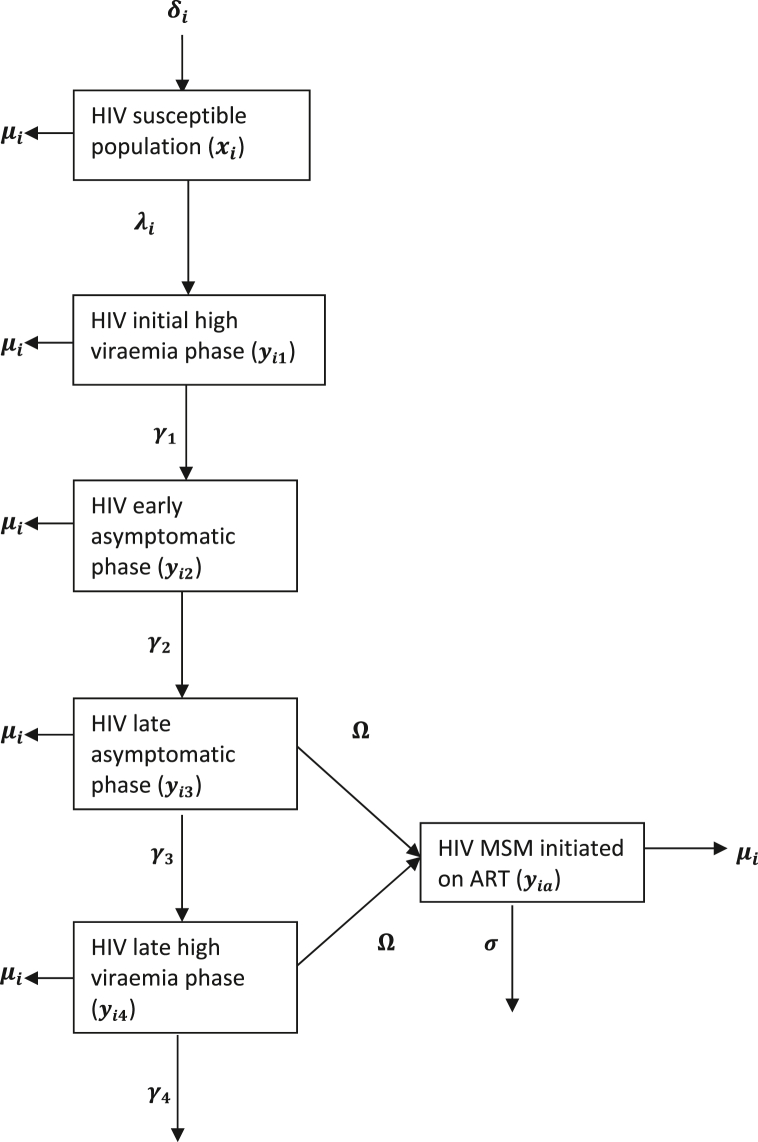
Schematic representation of model.